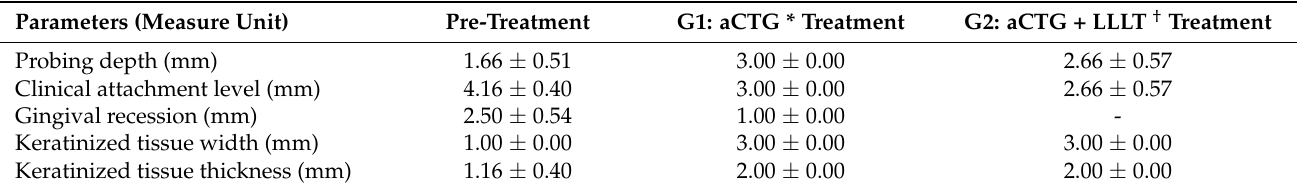
Table 2. Mean and standard deviation analysis at baseline and after 90